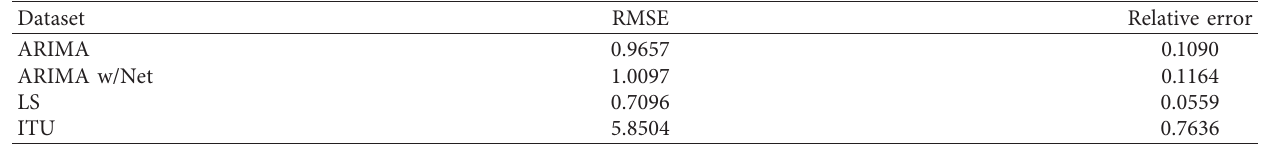
Table 14: ARIMA, ARIMA with neural network, LS, and ITU errors for